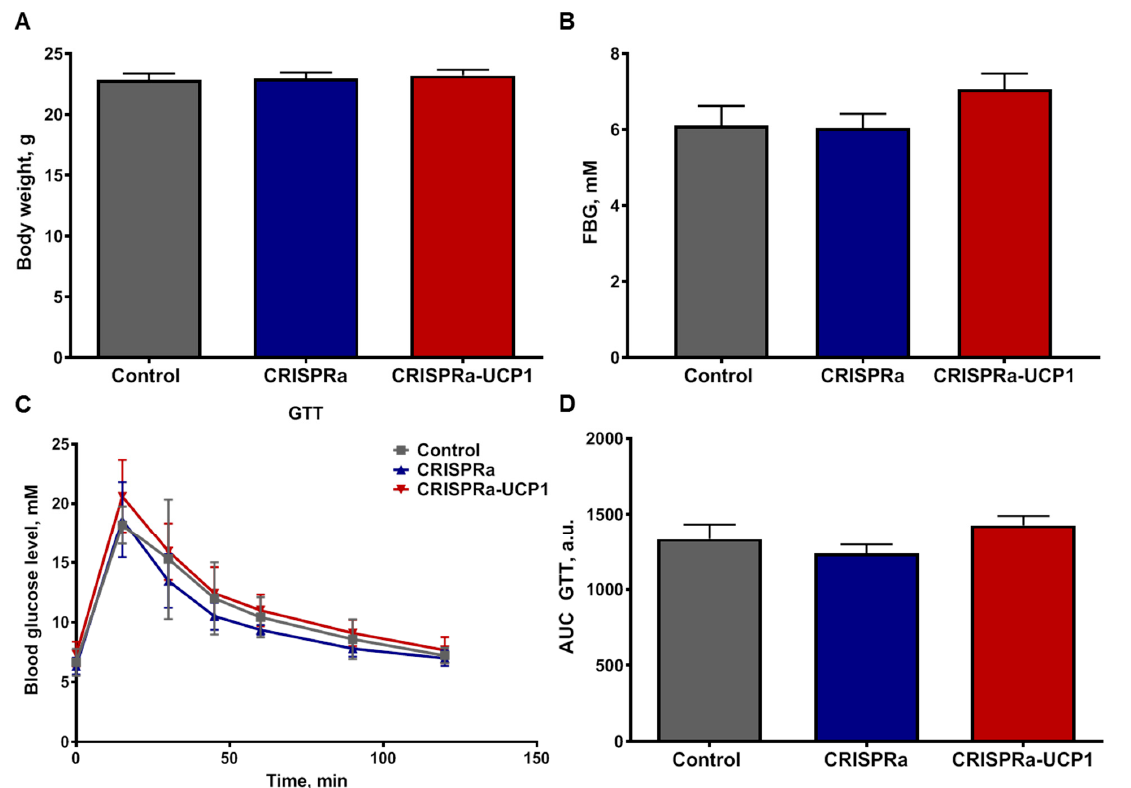
Figure 4. Metabolic parameters of recipient mice 7 days after transplantation of CRISPRa-modified adipocytes. ( A ) Body weight; ( B ) fasting blood glucose level (FBG); ( C ) kinetics of blood glucose level during GTT; ( D ) the area under the curve (AUC) of GTT. GTT—glucose tolerance test. Data are represented as mean ± SEM, Kruskel–Wallis test with post-hoc Dunn’s test, significance threshold p < 0.05.